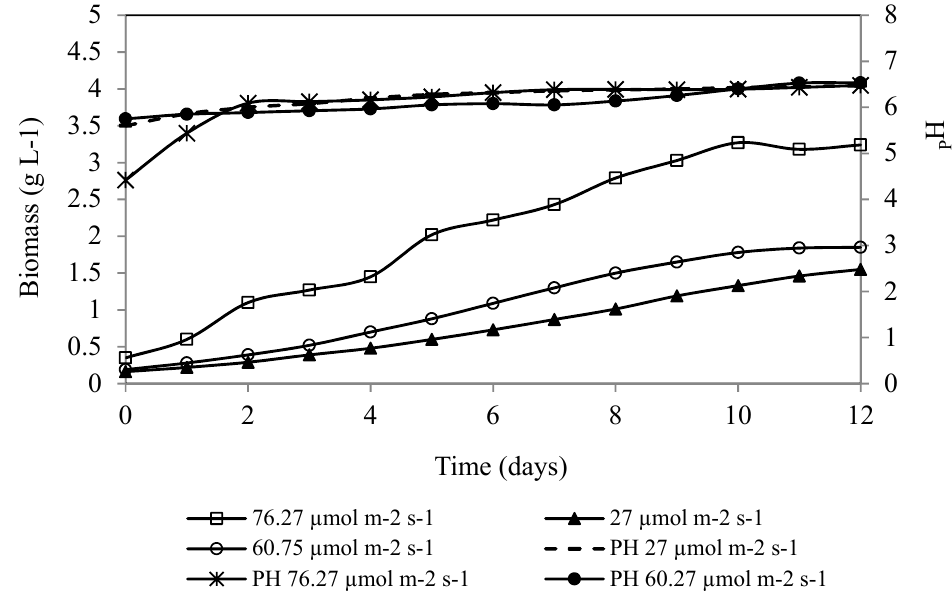
Figure 7. Effect of the light intensity on growth of S. dimorphus. Figure 7. E ff ect of the light intensity on growth of S.